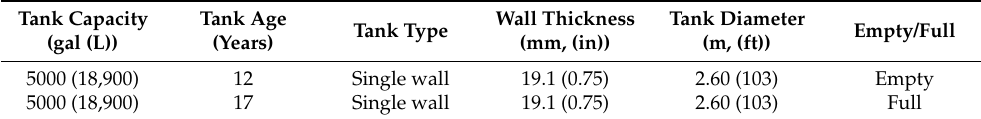
Table 9. Information on the two HDPE ASTs tested in the field.